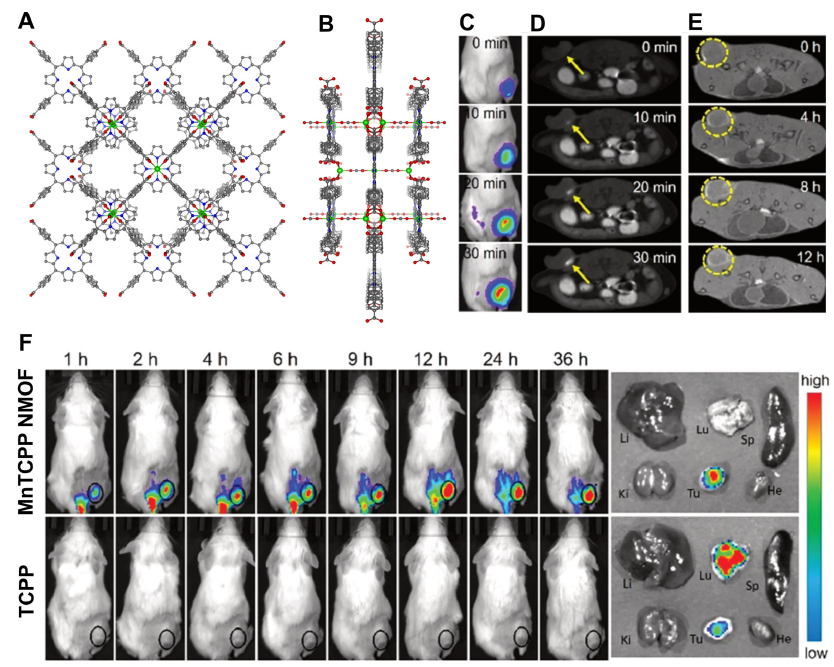
Figure 9. ( A ) Front and ( B ) side views of the Mn(III)TCPP NMOF. ( C ) Fluorescence and ( D ) T 1 con- trast signals in tumour sites by intra-tumoural injection of Mn(III)TCPP NMOF within 30 min. ( E ) In vivo MRI signal after intravenous injection with Mn(III)TCPP NMOF. ( F ) Fluorescence imaging of mice over time by intravenous injection of Mn(III)TCPP NMOF and tissue imaging at 36 h post- injection. Reprinted/adapted with permission from Ref. [99] .